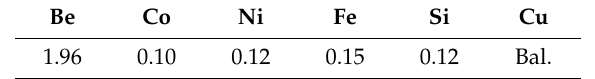
Table 1. The chemical composition of C17200 Cu alloy (wt.%).